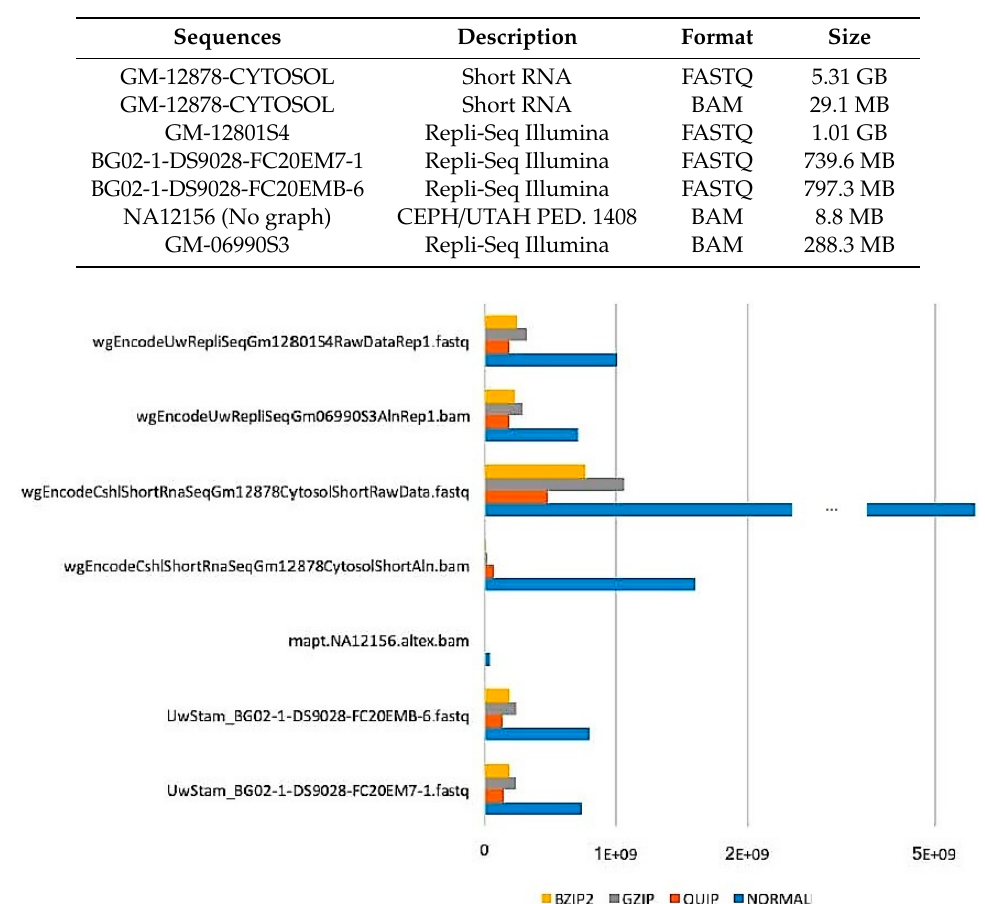
Figure 1. Quip, gzip, and bzip2: experimental results.